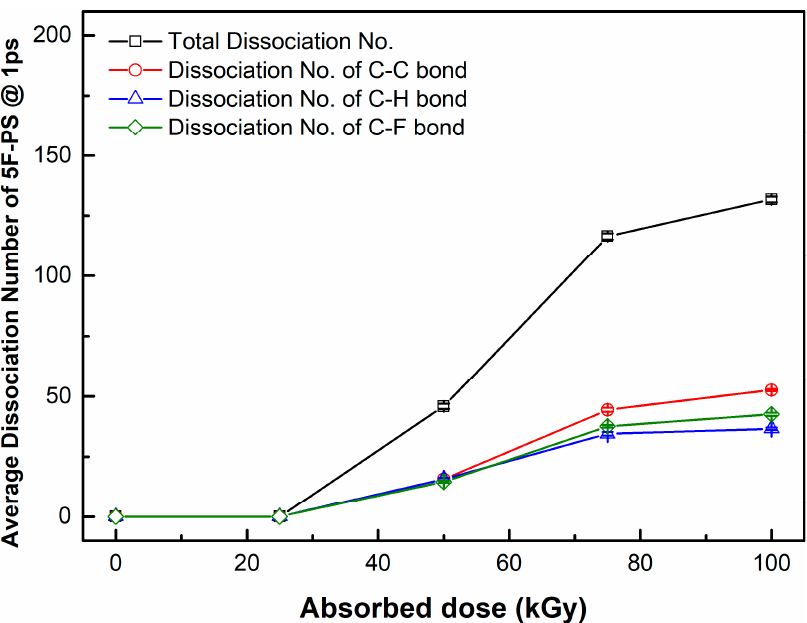
Figure 6. Average dissociation number of each bond in 1F-PS (poly(4-fluorostyrene)) at 1 ps.